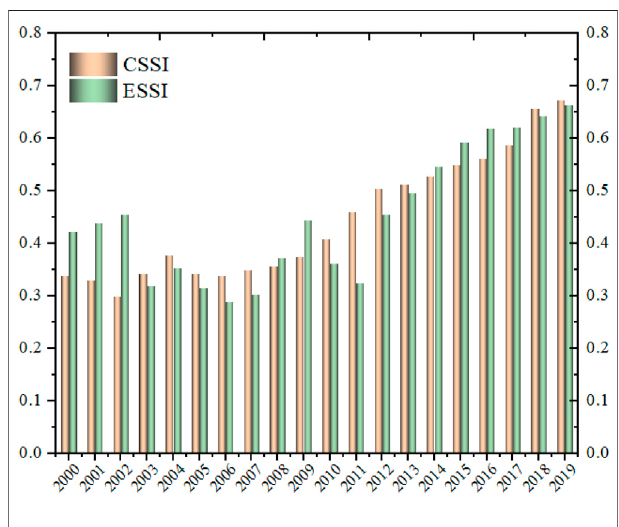
FIGURE 12 | Comparison of CSSI and ESSI